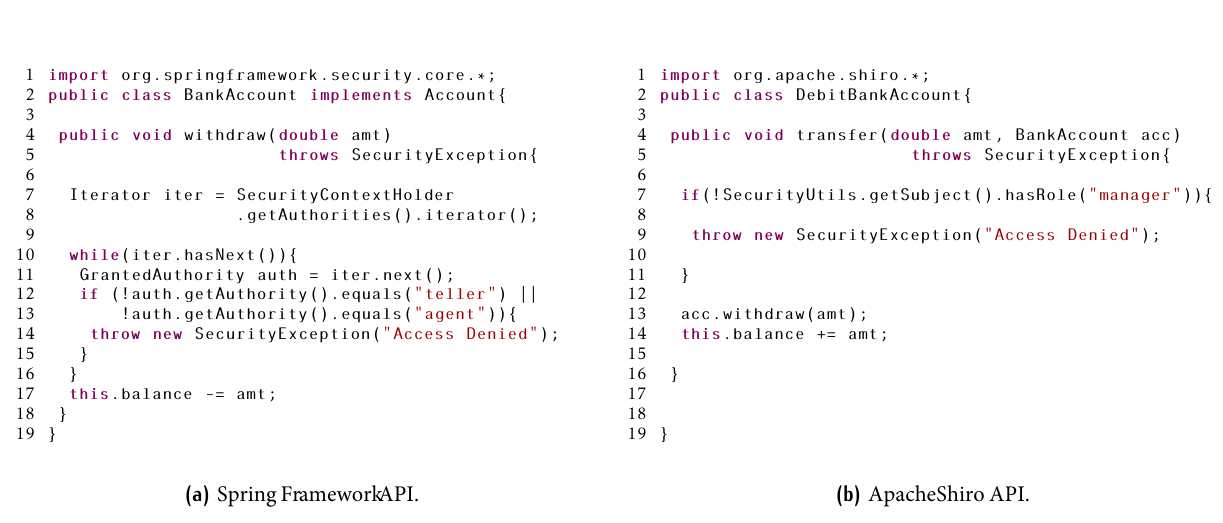
Figure 2. A Sample Policy Usingthe RBACXACMLProfile